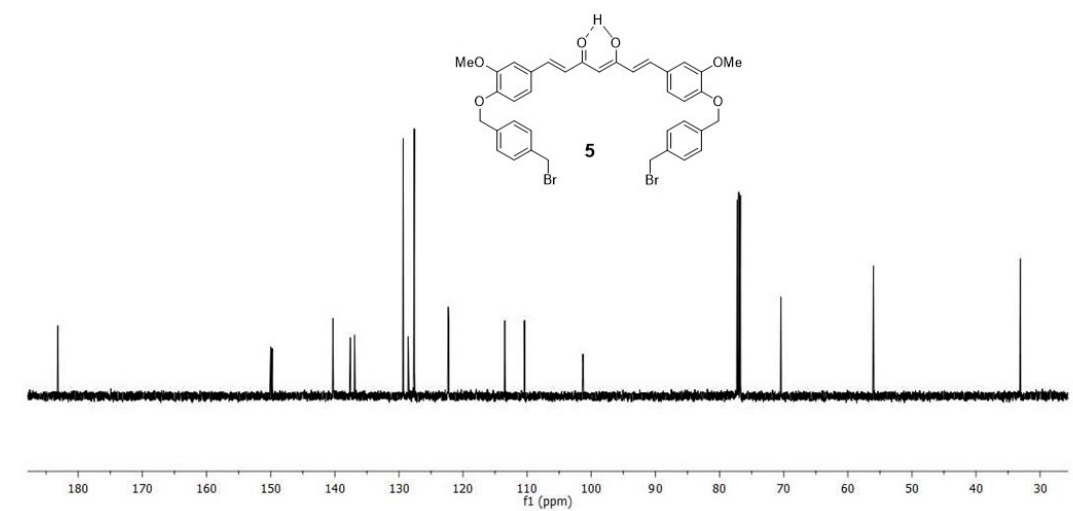
Figure 15. 13 C NMR spectrum of Compound 5 in CDCl 3 as solvent.